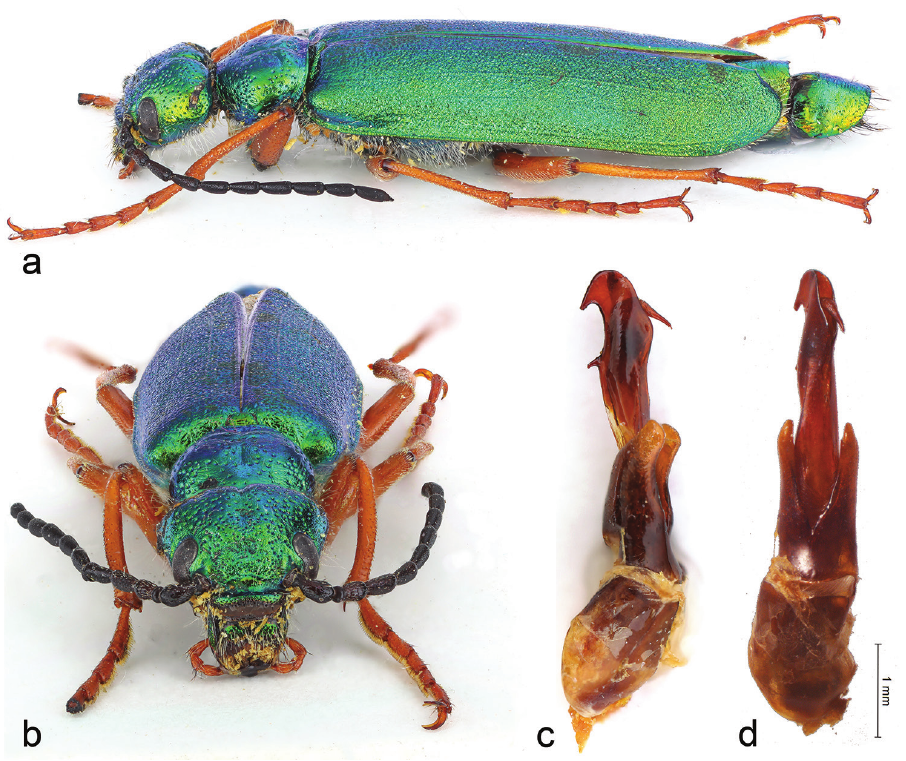
Figures 2. Teratolytta krejciki sp. n., male: a habitus lateral view b head, frontal view c tegmen and aedeagus, lateral view d tegmen and aedeagus, ventral